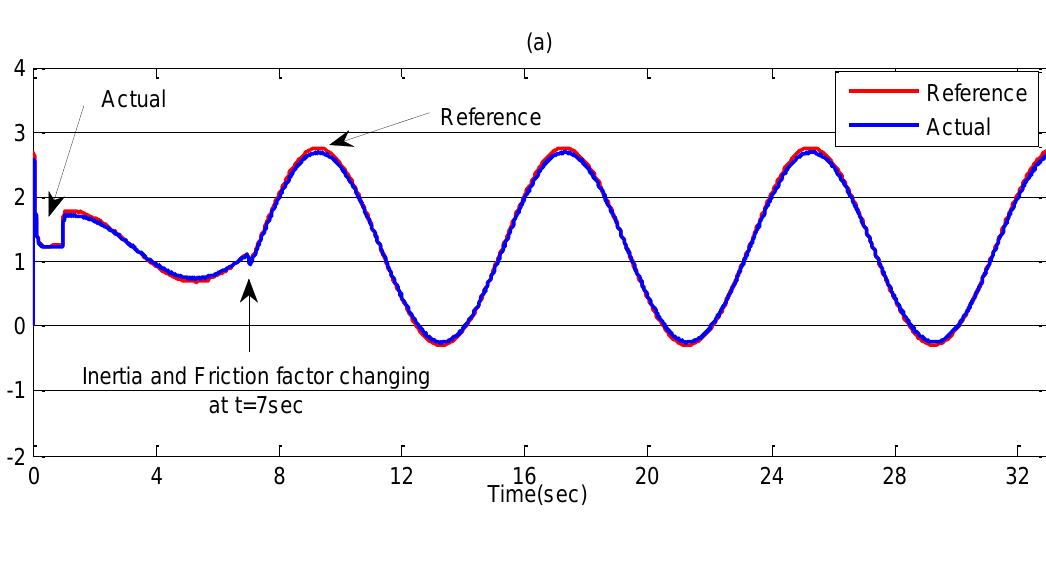
Figure 12. Simulated q-axis current responses-based IM drive in Case-3 ; ( a ) the tuned PI controller, ( b ) the conventional BLFC controller, and ( c ) the proposed NBLFC